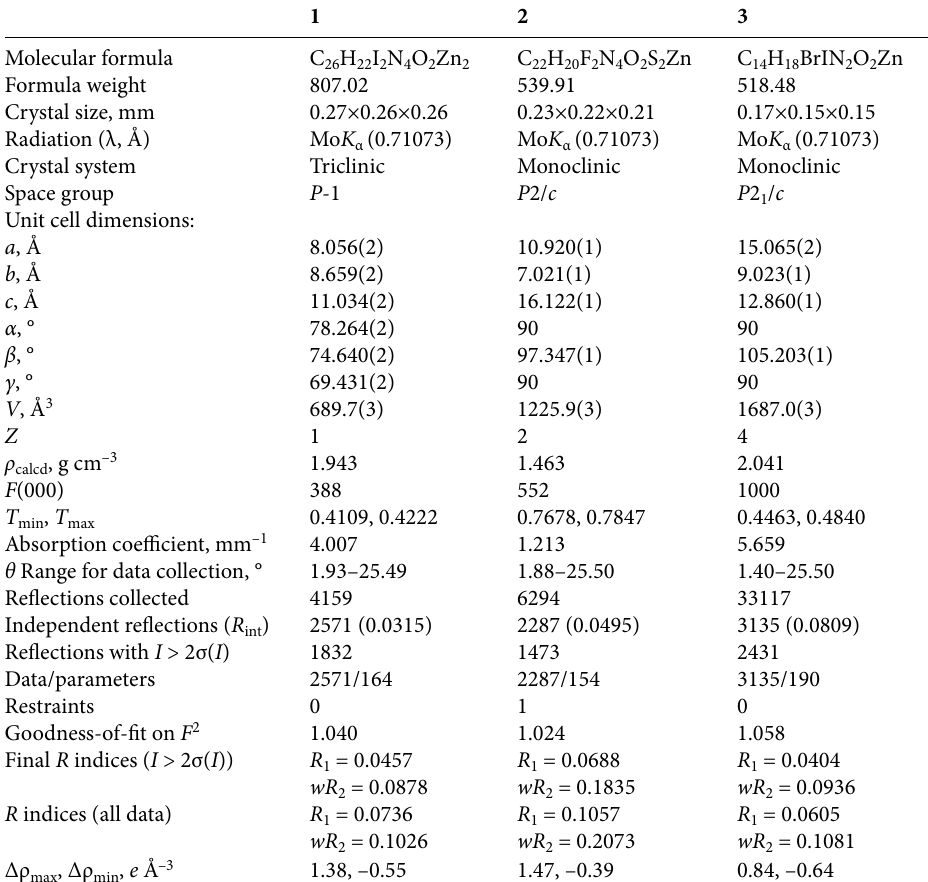
Table 1. Crystallographic data and experimental details for the